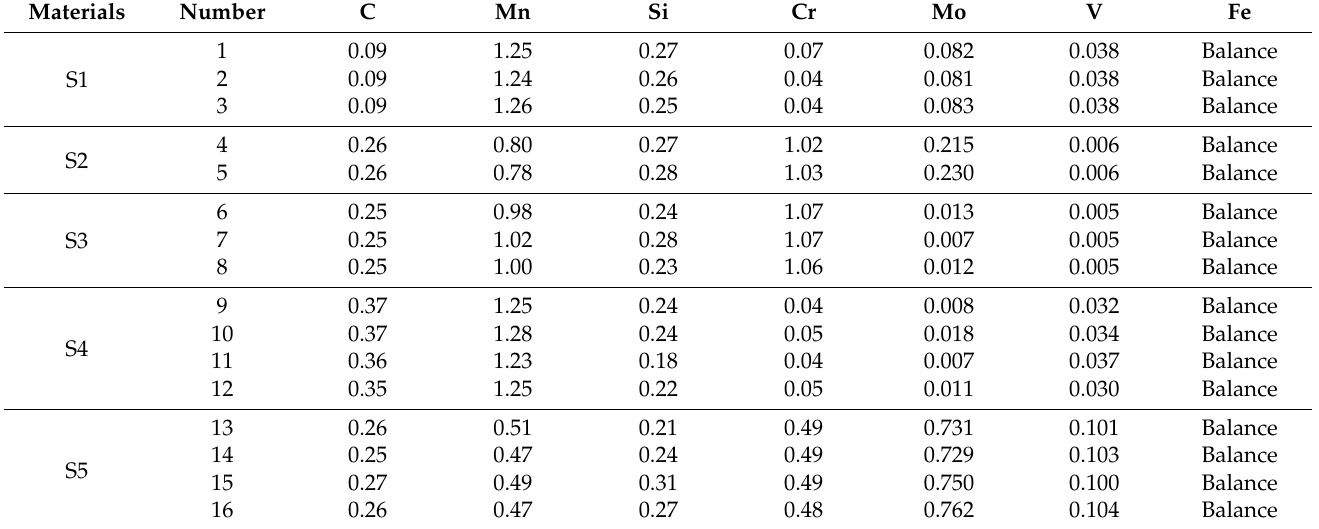
Table 1. Experimental steels and the alloy composition